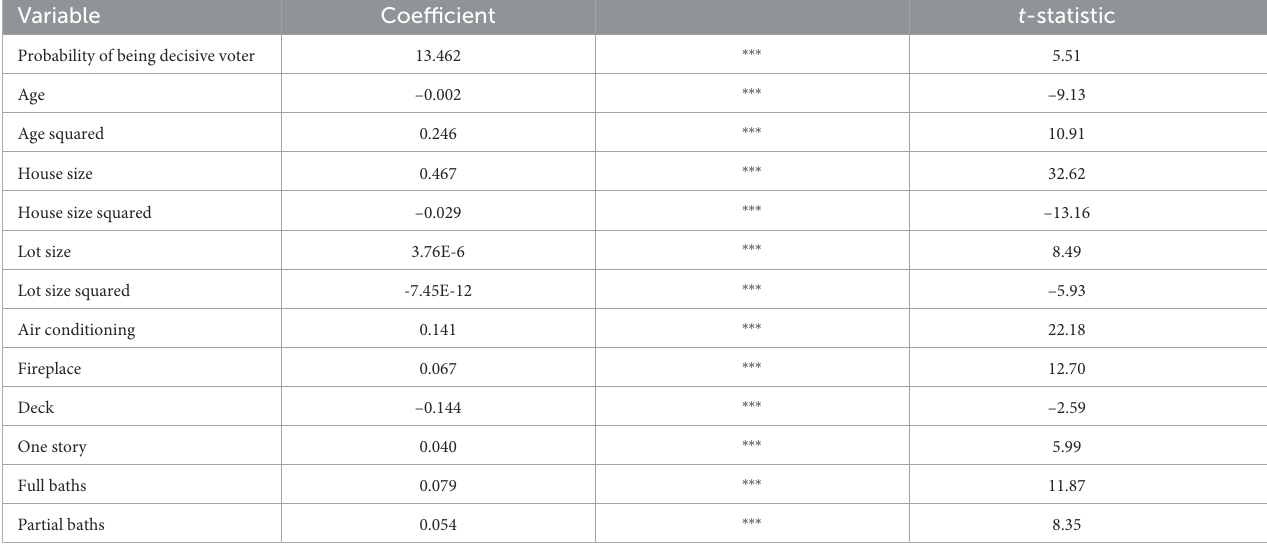
TABLE 3 Determinants of housing prices in Columbus, Ohio